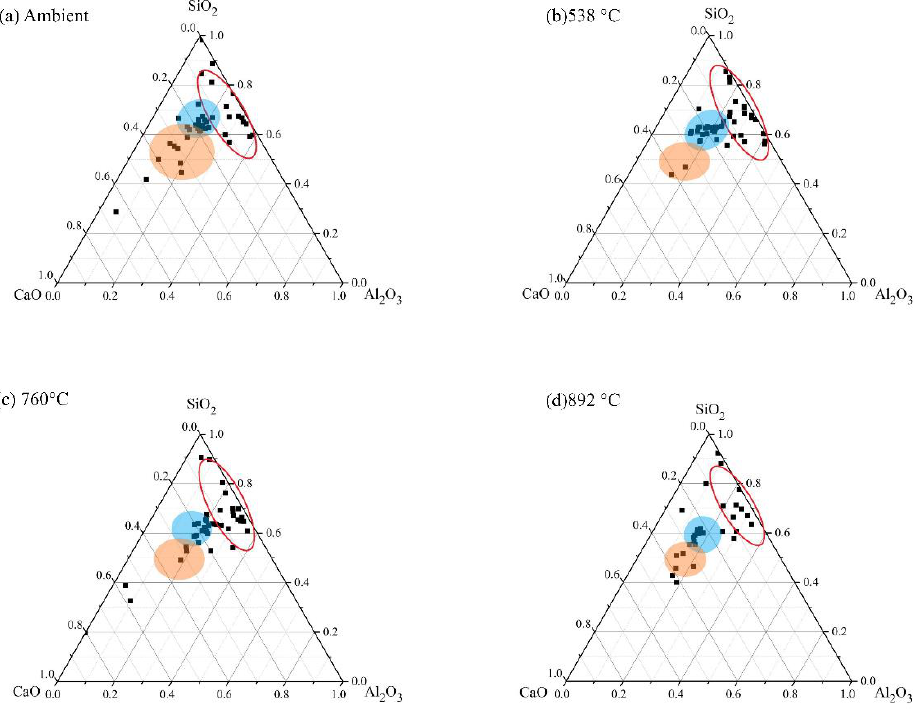
Figure 22. Ternary representation of EDS data for FS 40P-1.4 exposed to high temperatures.